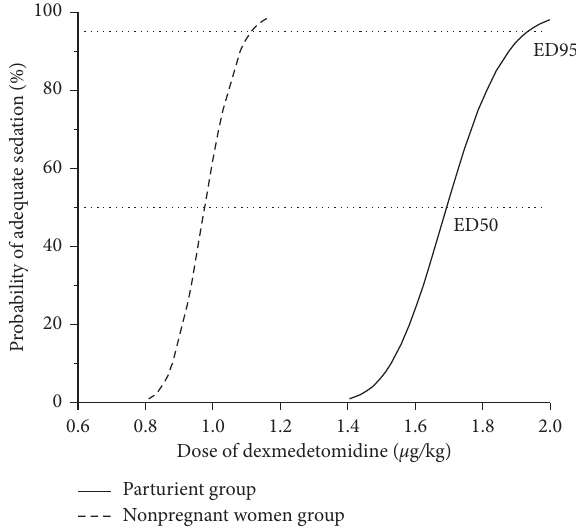
Figure 2: Dose-response curves plotted from the Probit analysis of individual dexmedetomidine sedation in postpartum parturient group and nonpregnant women group. ED50, the median effective dose; ED95, the 95% effective